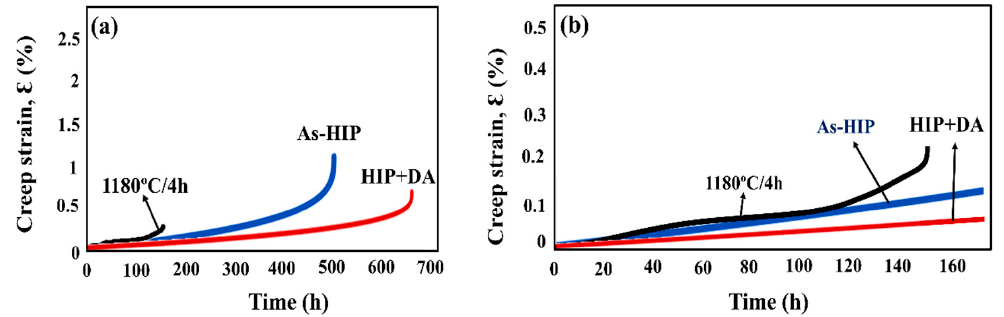
Figure 12. ( a ) Creep curves of post-processed specimens under 650 °C /550 MPa and ( b ) in the early stage of the initial 165 h.